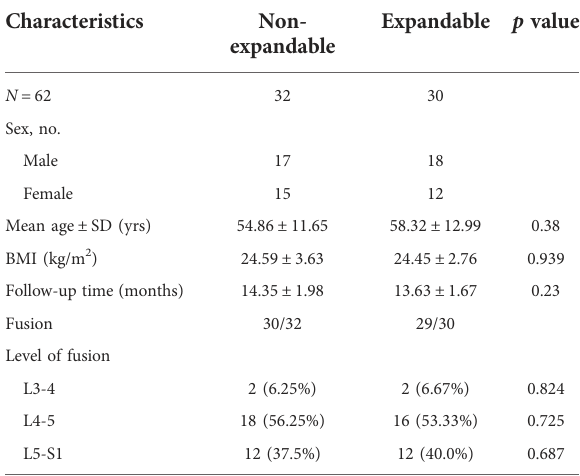
TABLE 1 Comparison of demographic and clinical characteristics between patients instrumented with EXP-IFC and NE-IFC Characteristics